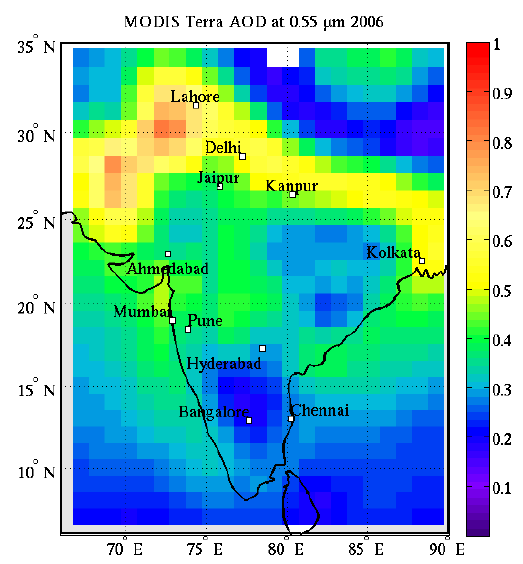
Fig. 6. AOD in India according to MODIS C5 data for 2006 (annual average, unitless).